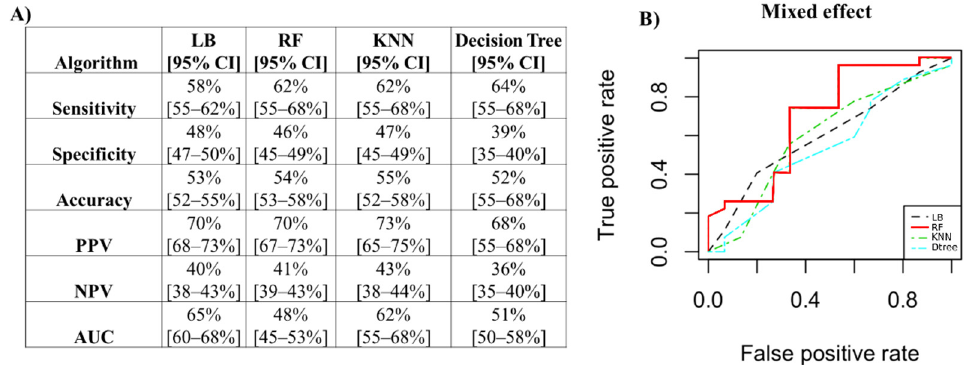
Figure 9. Performance measures to classify patients with positive biopsies for the mixed effect method. ( A ) Algorithm performance via PCs to classify patients with positive biopsies for the mixed effect method. ( B ) ROC curves of the four classifiers. PPV: positive predictive value; NPV: negative predictive value; AUC: area under the curve; LB: LogitBoost; RF: random forest; KNN: k-nearest neighbors; CI: confidence interval.